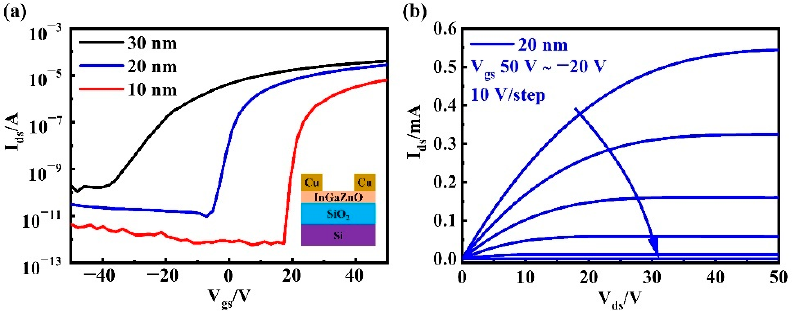
Figure 3. ( a ) Transfer characteristic curves of TFTs with a-InGaZnO active layers of different thick- nesses (inset is the cross section of a-InGaZnO TFT). ( b ) Output characteristic curve of a-InGaZnO TFT when the active layer is 20 nm.